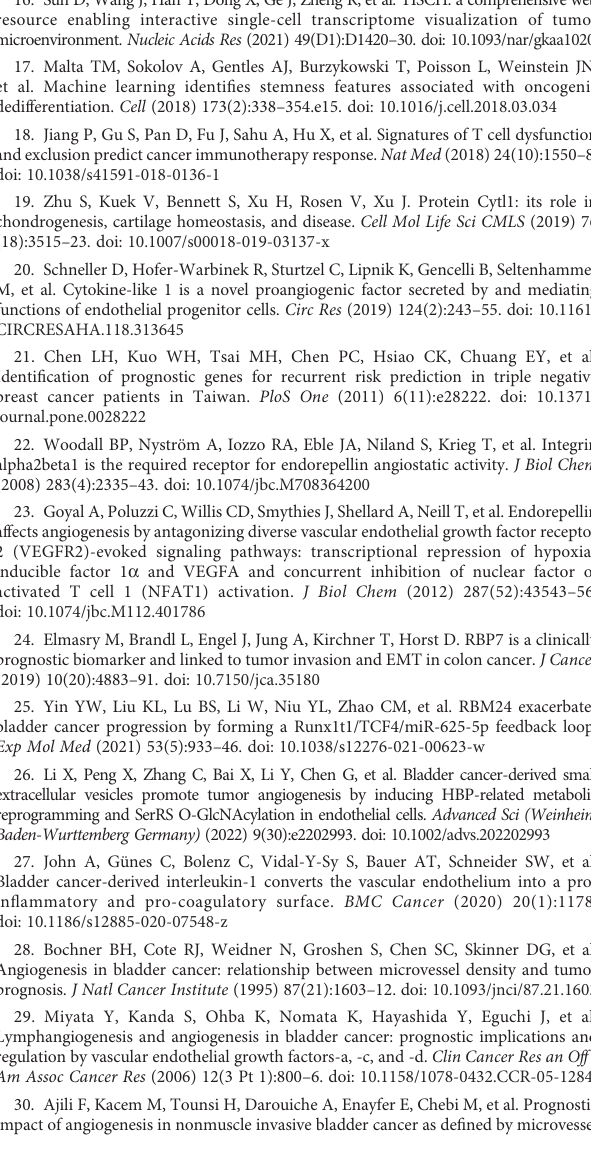
SUPPLEMENTARY FIGURE 1 The correlation between TIDE score and endothelial cells (A) , the MSI Expr Sig scoreinthehighandlowendothelialcells (B) ,theT-cellexclusionscorebetween the high and low endothelial cells (C) , the T-cell dysfunction score between the high and low endothelial cells (D) , the number of the patients with or without response to immunotherapy betwee the high and low endothelial cells (E)